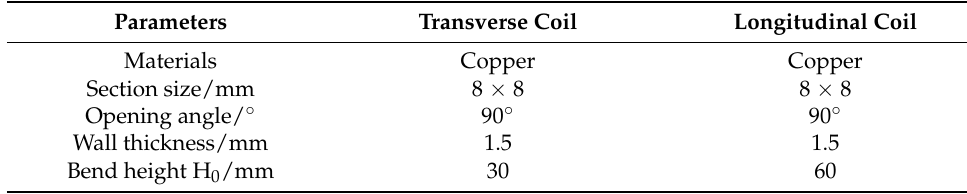
Figure 3. Two induction coil structures: ( a ) transverse coil, ( b ) longitudinal coil. Table 2. Induction heating coil parameters.